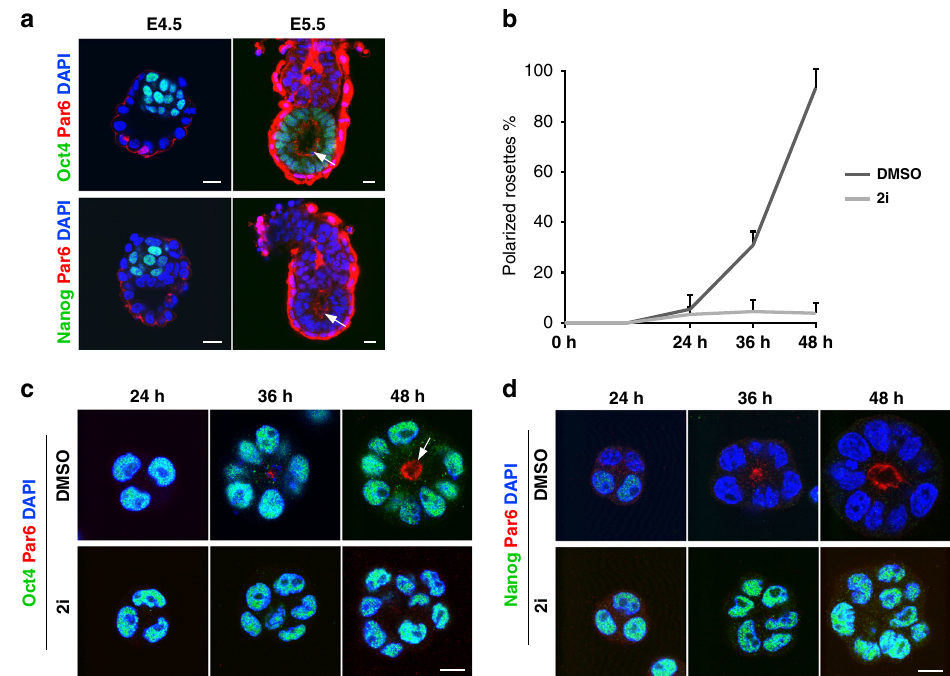
Fig. 1 ES cells self-organisation in 3D in vitro model of early epiblast morphogenesis. a E4.5 blastocyst and E5.5 egg cylinder-stage embryos stained for the epithelial polarity marker Par6. The apical domain (arrow) in the E5.5 epiblast surrounds the proamniotic cavity. The epiblast is marked by Oct4 (top panel). The naive pre-implantation epiblast is marked by Nanog (bottom panel), and the nuclei are counterstained with DAPI. b Establishment of epithelial rosettes in 3D ES cell culture. Wild-type E14 ES cells were cultured in N2B27 medium supplemented with DMSO (control) or 2i for 24, 36 and 48 h. Data represent mean ± SD, three independent experiments. c Wild-type E14 ES cells grown in 3D culture conditions in the presence of DMSO or 2i for 24, 36 and 48 h and stained for Par6, Oct4 and DAPI. The apical domain surrounding the lumen is marked by an arrow. d Wild-type E14 ES cells grown in 3D culture conditions in the presence of DMSO or 2i for 24, 36 and 48 h and stained for Par6, Nanog and DAPI. Scale bars, 10 µ